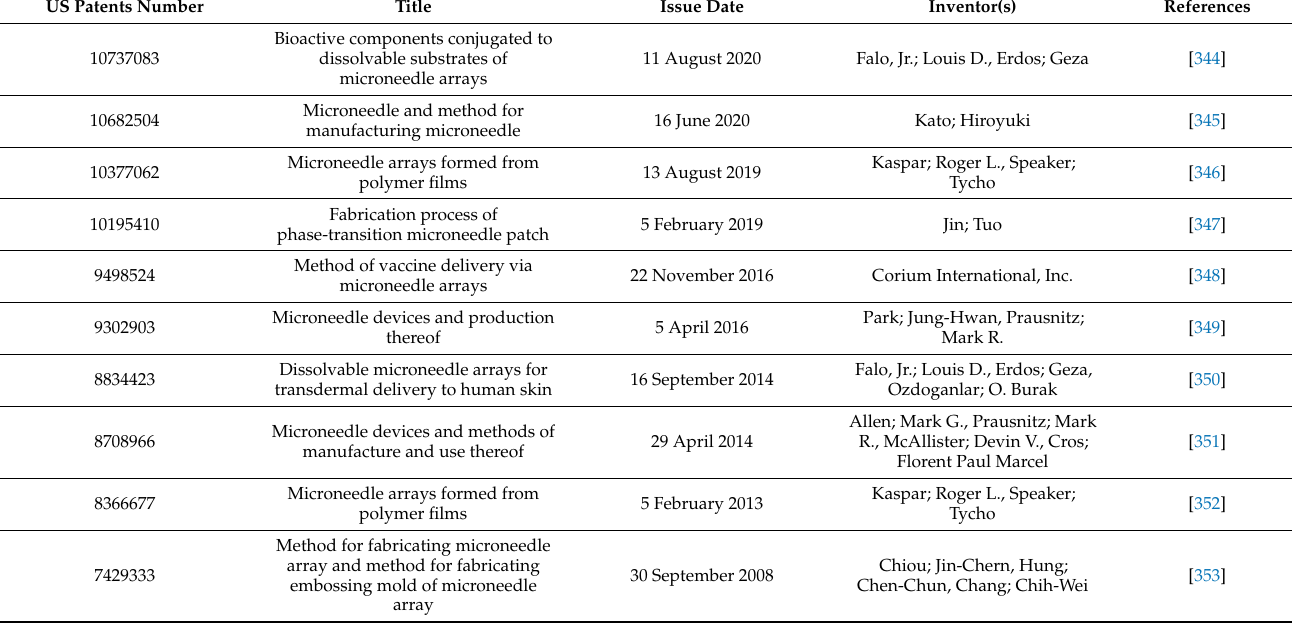
Table 5. List of US patents related to polymeric MN technology. Information collected from the United State Patent and Trademark Office database (Information accessed on 21 February 2021 at http://patft.uspto.gov/netahtml/PTO/search- bool.html).